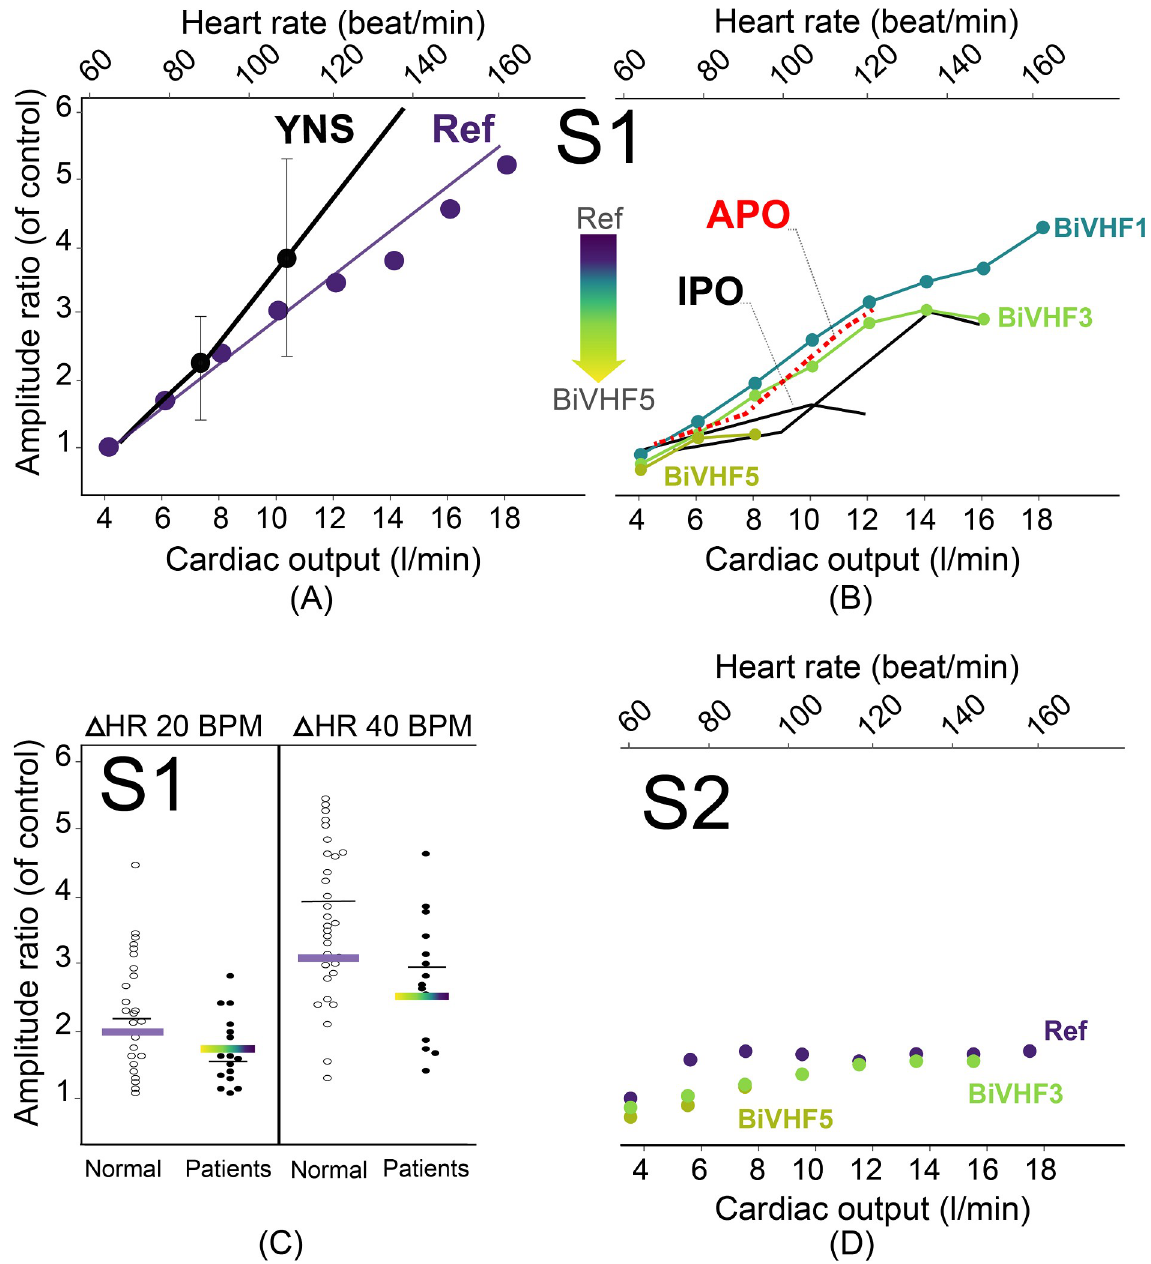
Fig 5. Relationship between heart rate and amplitudes of S1 and S2. The amplitudes are normalized to the control. All the experimental data (black dots and lines) are adapted from the figures in the article by Bergman and Blomqvist 1975 [25] in which patients have at least one major coronary artery with reduced vessel diameter by 50%. (a) A linear relationship between S1 amplitude and exercise level in normal condition for both simulation and experiment. (b) Simulated biventricular heart failure causes a reduction in S1 amplitude which is in agreement with the abnormal experimental data. (c) Average of S1 amplitude for both normal and abnormal simulations is within the range of experimental data. (d) Exercise doesn’t change S2 amplitude significantly compared to S1. APO : average of patient observations, BPM : beat per minute, BiVHF1- 5 : biventricular heart failure levels, HR : heart rate, IPO : individual patient observations, Ref : reference, YNS : young normal subjects. LVHF severity, the splitting interval did not depend on RVHF severity. Splitting was the largest in resting condition when the level of heart failure (both left and right) severity was the highest.